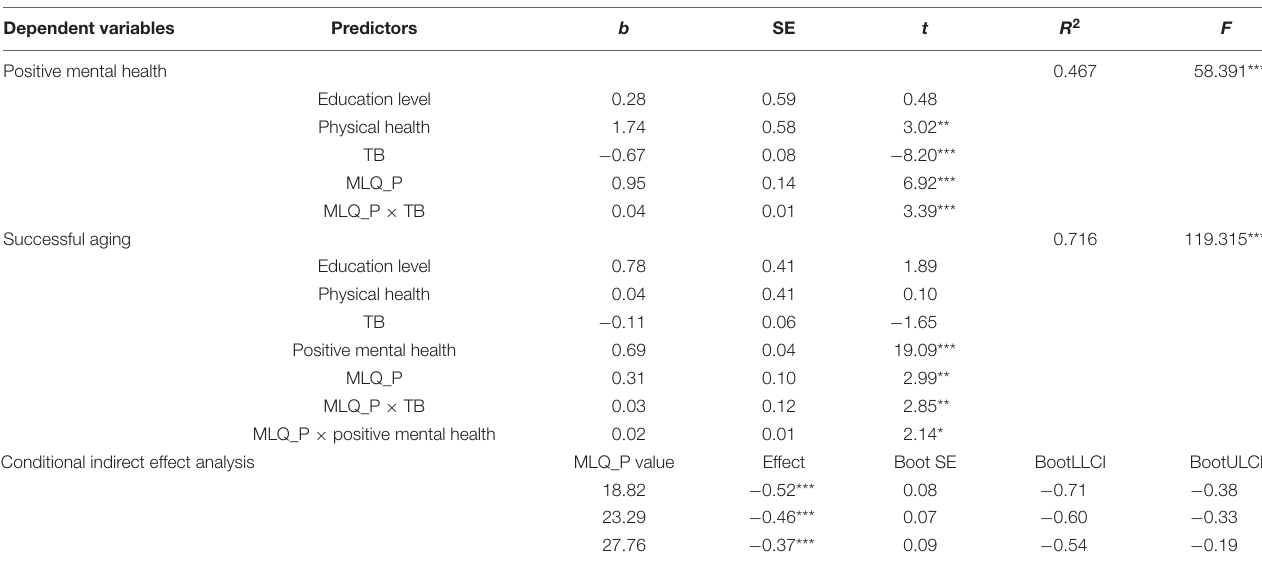
TABLE 3 | Testing the moderated mediation effect (MLQ_P as a